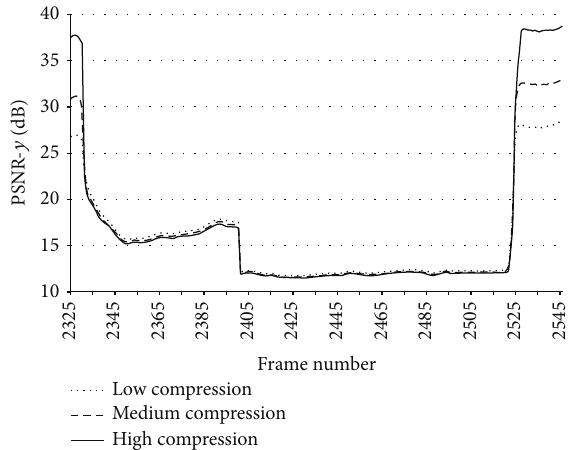
Figure 9: PSNR frame values during a long packet loss burst (from frame 2327 to 2525) at different